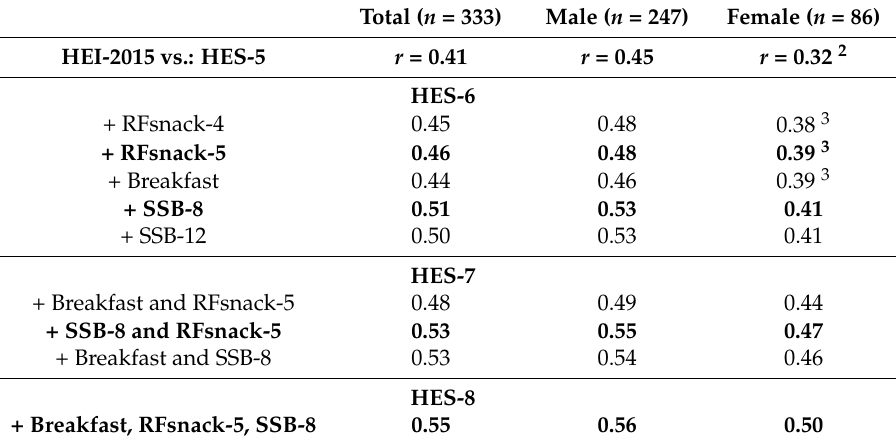
Table 2. Correlations between HEI-2015 and candidate HES-5+ scores among CHAMP CSF2 Study participants ( n = 333) 1